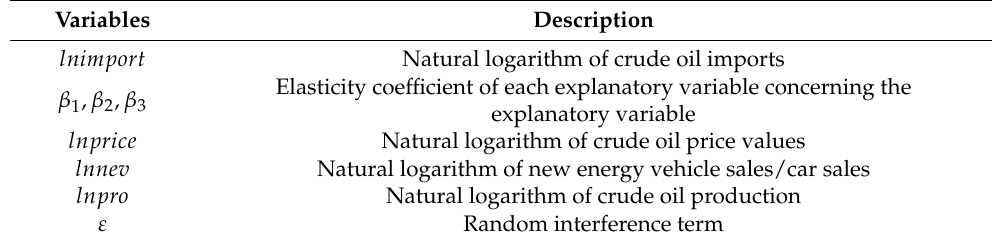
Table 2. Description of model